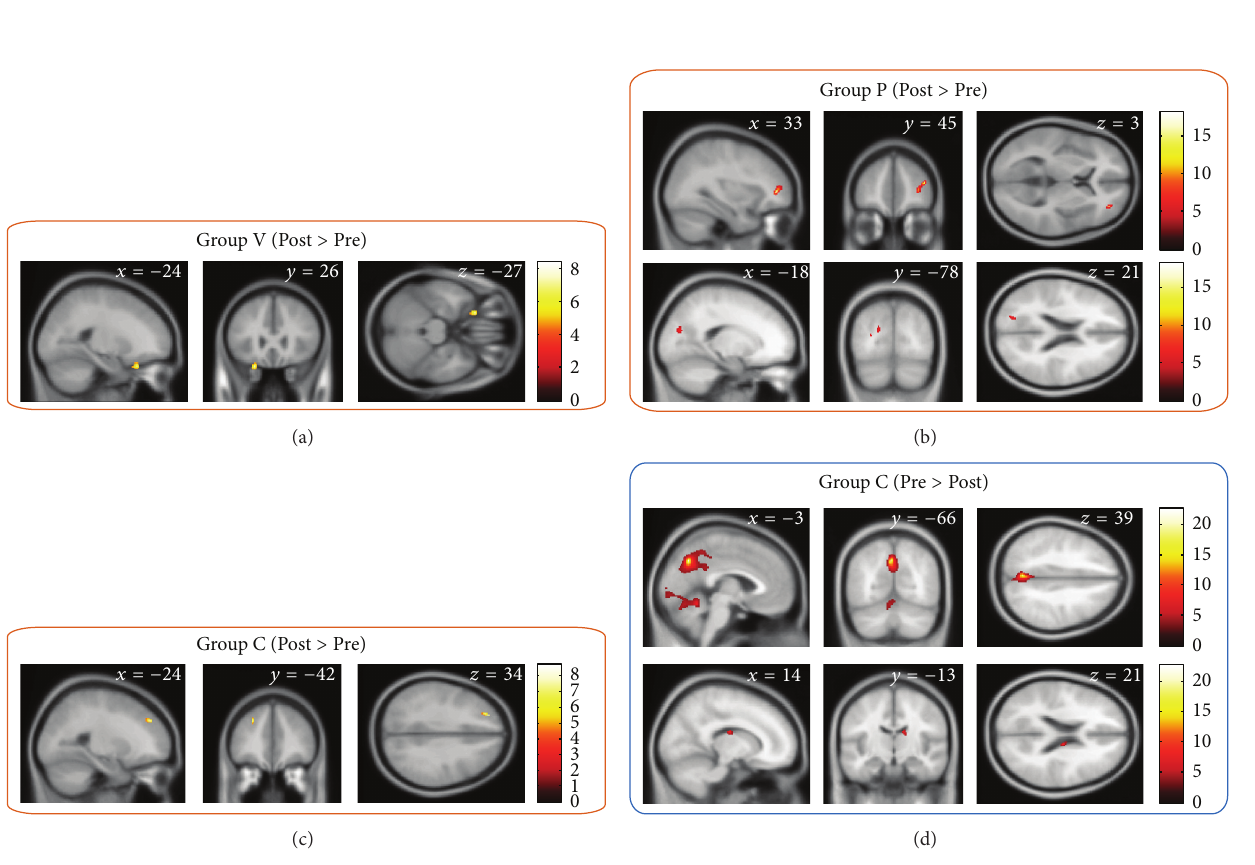
Figure 3: Group V showed significant rGMV increases in the left inferior frontal gyrus (a). Group P showed significant rGMV increases in the right middle frontal gyrus and the left superior occipital gyrus (b). Group C showed significant rGMV increases in the left dorsolateral prefrontal cortex (c) and significant rGMV decreases in the precuneus, the medial cerebellum, and the right caudate (d). The colored clusters show regions with rGMV changes that were significant with a family-wise error corrected 𝑃 < 0.05 at the nonisotropic adjusted cluster level [59], with an underlying voxel level of 𝑃 < 0.001